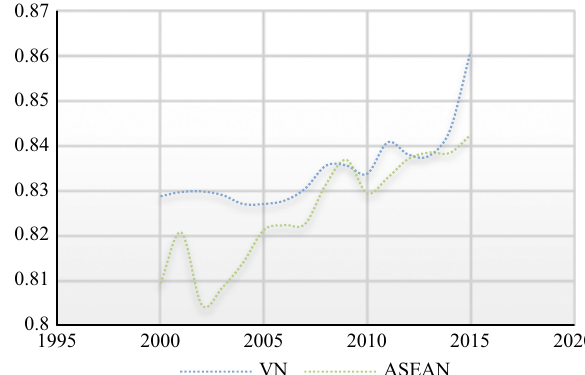
Figure 6. SEMSFA ’ s efficiency with